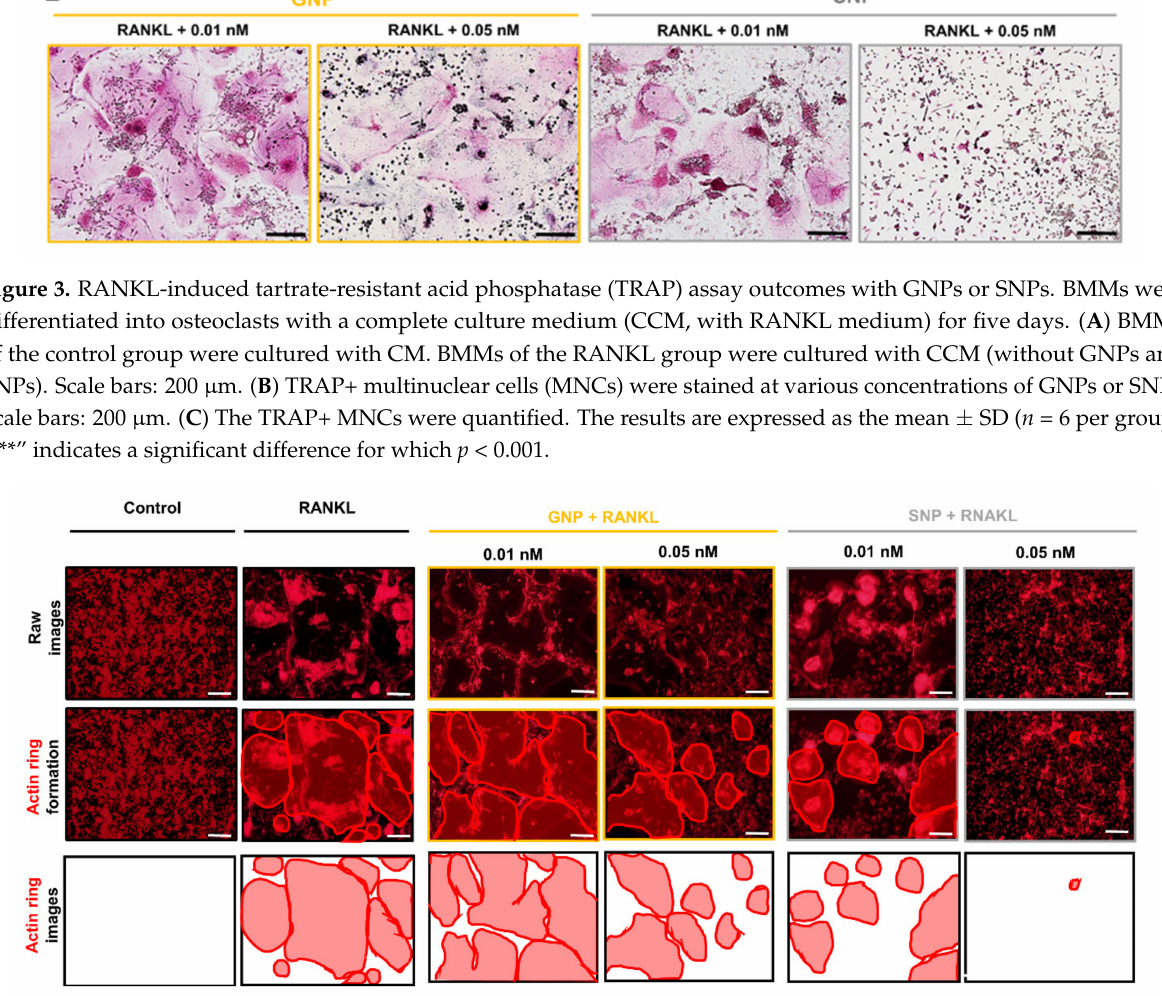
Figure 4. RANKL-induced actin ring structure with GNPs or SNPs for five days. BMMs were cultured at various concentrations of GNPs or SNPs. Scale bars: 200 µ m. The results are expressed as the mean ± SD ( n = 3 per